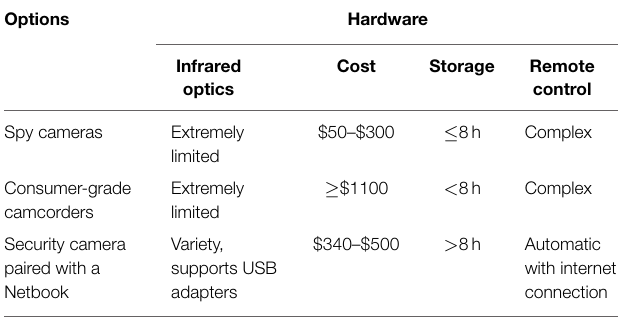
TABLE 1 | Hardware option test process .